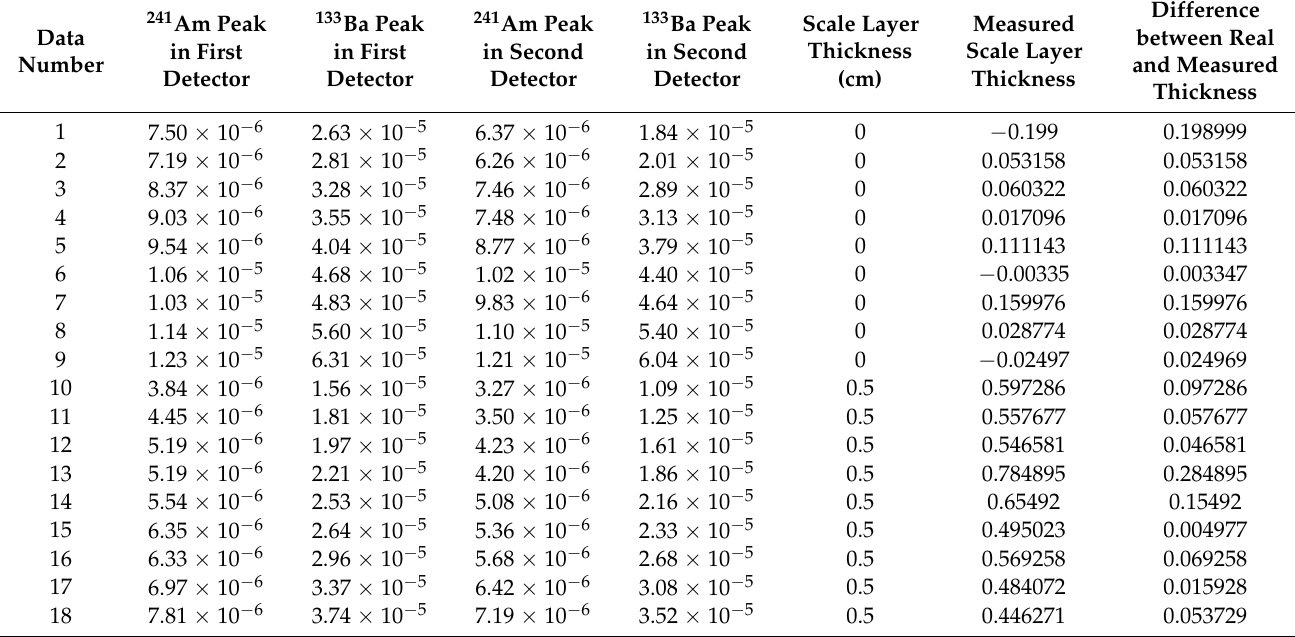
Table 2. The input matrix, output matrix, and measured data (network output) for the testing set (54 cases).